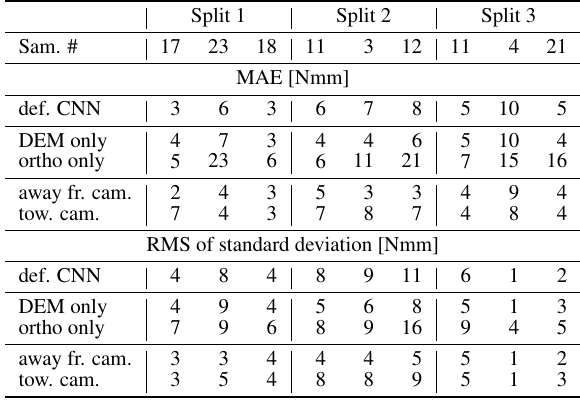
Table 4. Variation of input sources: MAE and RMS of the standard deviation of the 9 predicted support points.